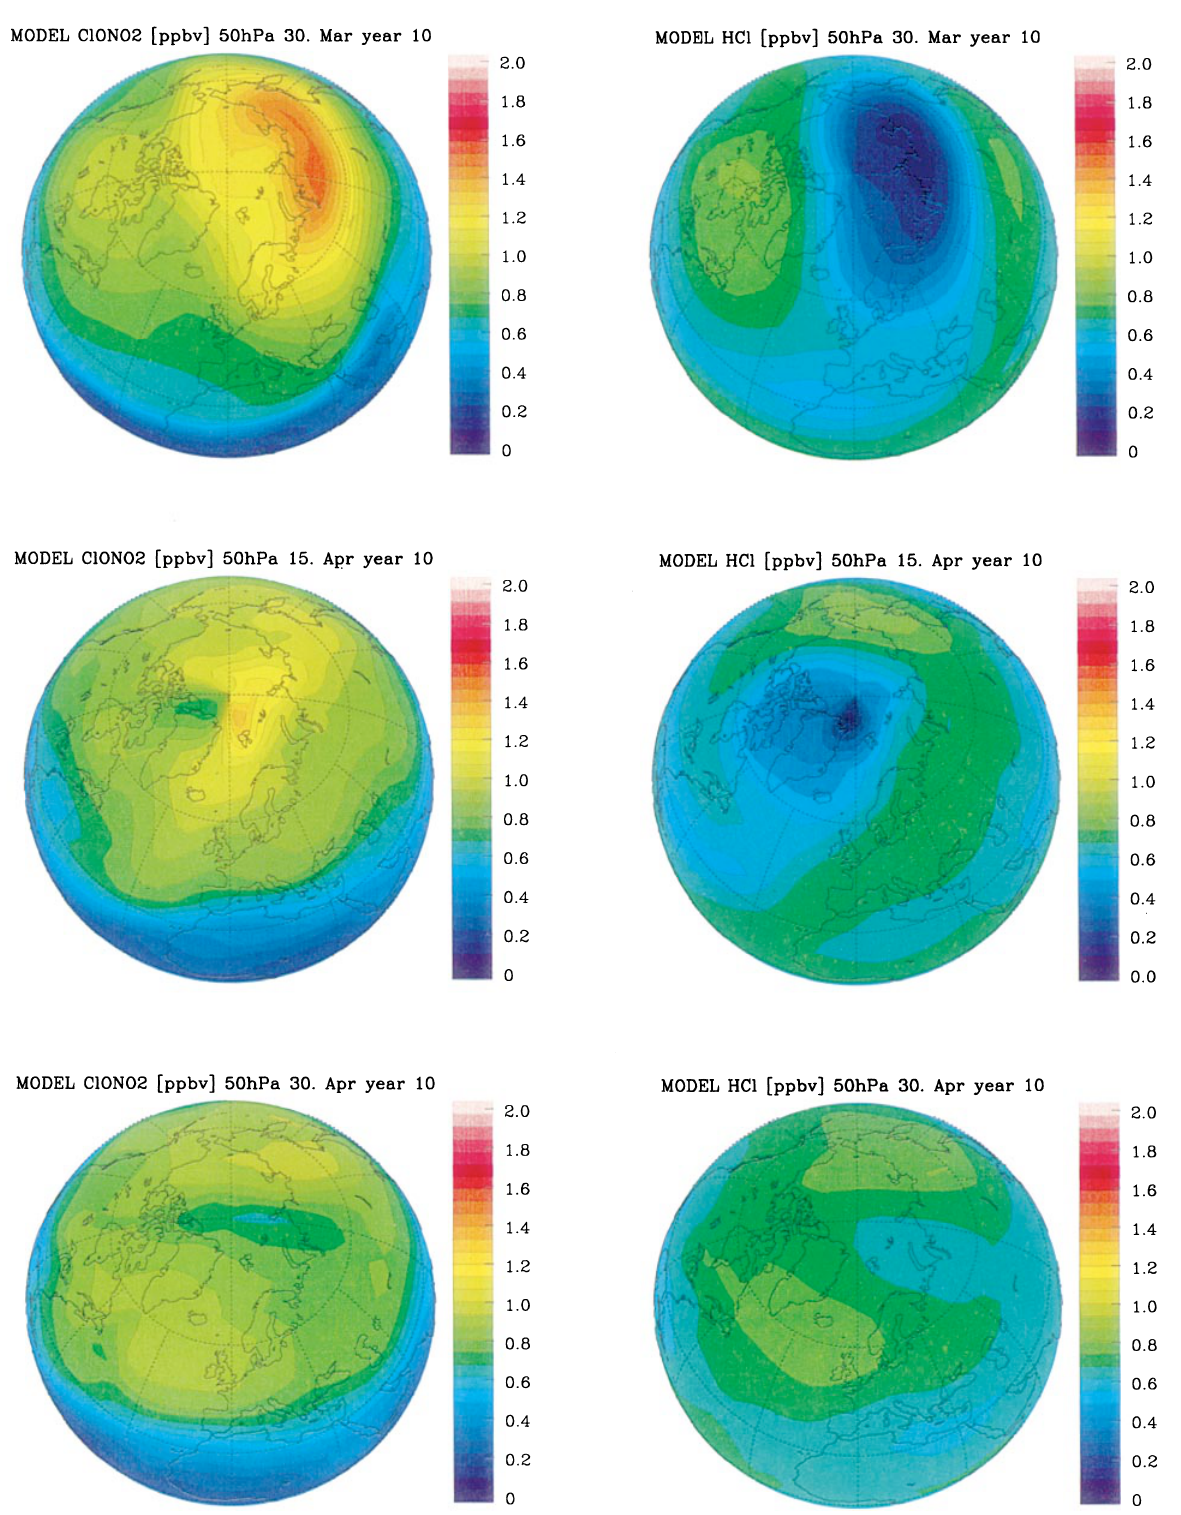
Fig. 15. Northern-hemisphere charts of ClONO ( left-hand side ) and HCl ( right-hand side ) for 30 March, 15 and 30 April of model year 10 at 2 50 hPa. Units are HALOE satellite data, indicates strengths and weak- variability, are reproduced. The model describes the nesses of the model with respect to the simulation of the vertical ozone distribution qualitatively satisfactorily, ozone distribution. The main climatological features, i.e. even in the troposphere. the mean distribution and the intra- and interannual